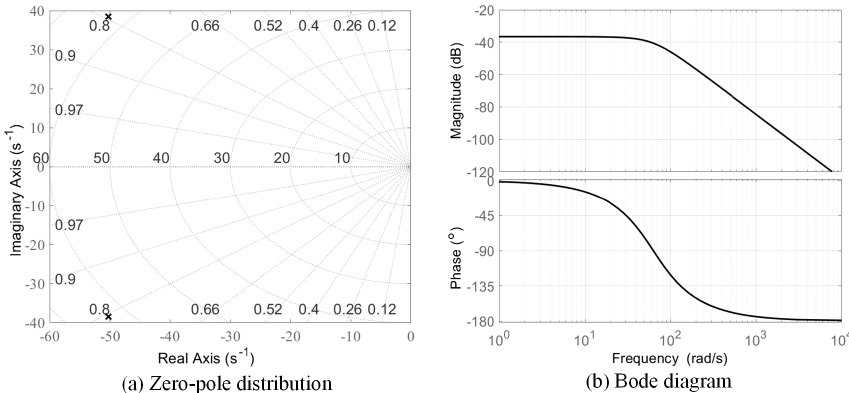
Figure 14. Zero-pole distribution of transfer function and Bode diagram.